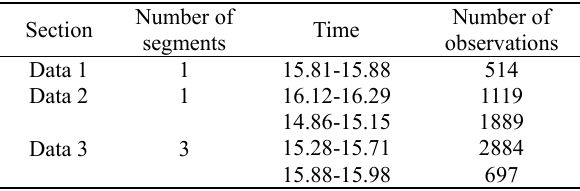
Table 2 . Information of observation data.